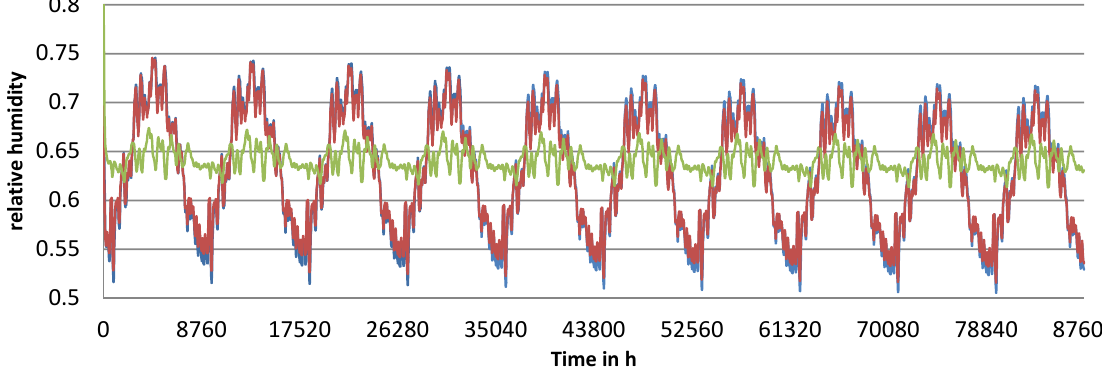
Figure 5. Relative humidity at Rec Position 3, in the middle of insulation; (blue) MiWo, (red) Sheep wool and (green) CaSi.